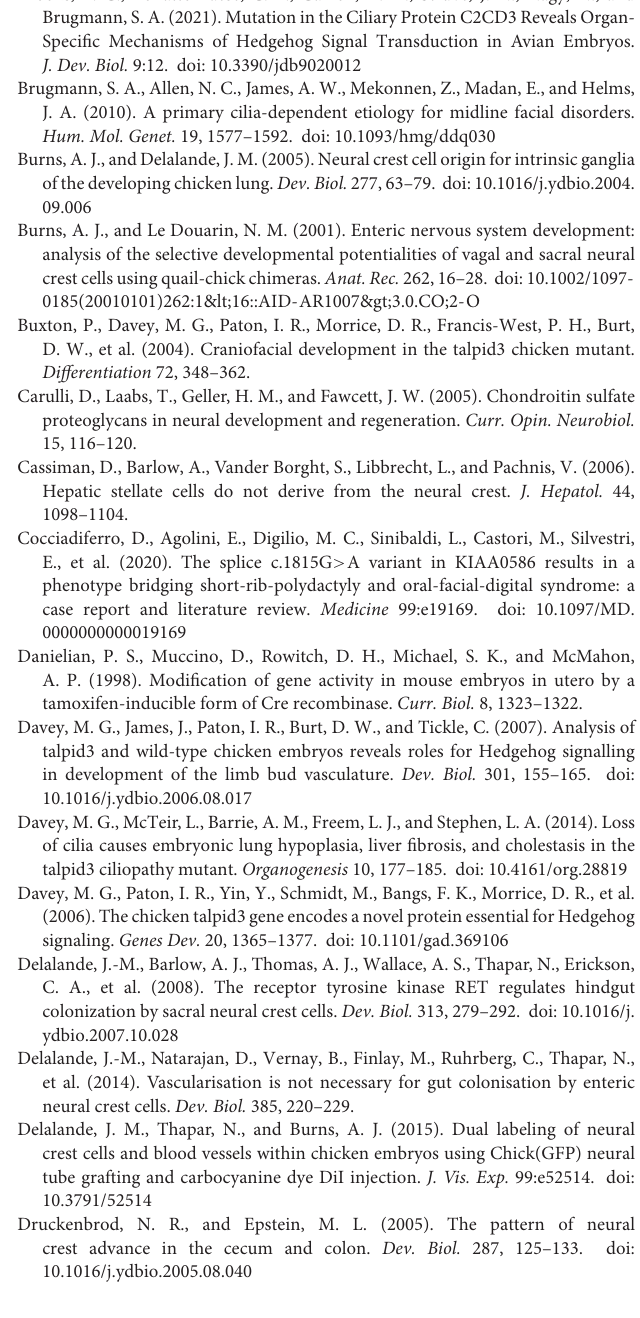
control and KIAA0586 mutated tissue. (C + insets) Week 19 control intestine shows strong expression of patched in the epithelium, in the myenteric plexus